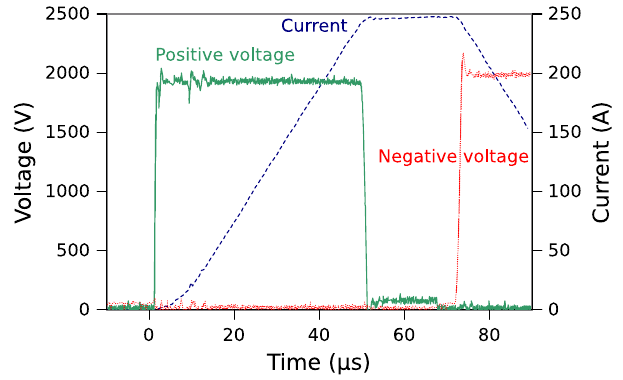
FIG. 12. Measured power-supply waveforms for 250 A de- manded flat-top current, with 30 m of cable: Positive-side output voltage (green solid trace); negative-side output voltage (red dotted trace); output current (blue dashed